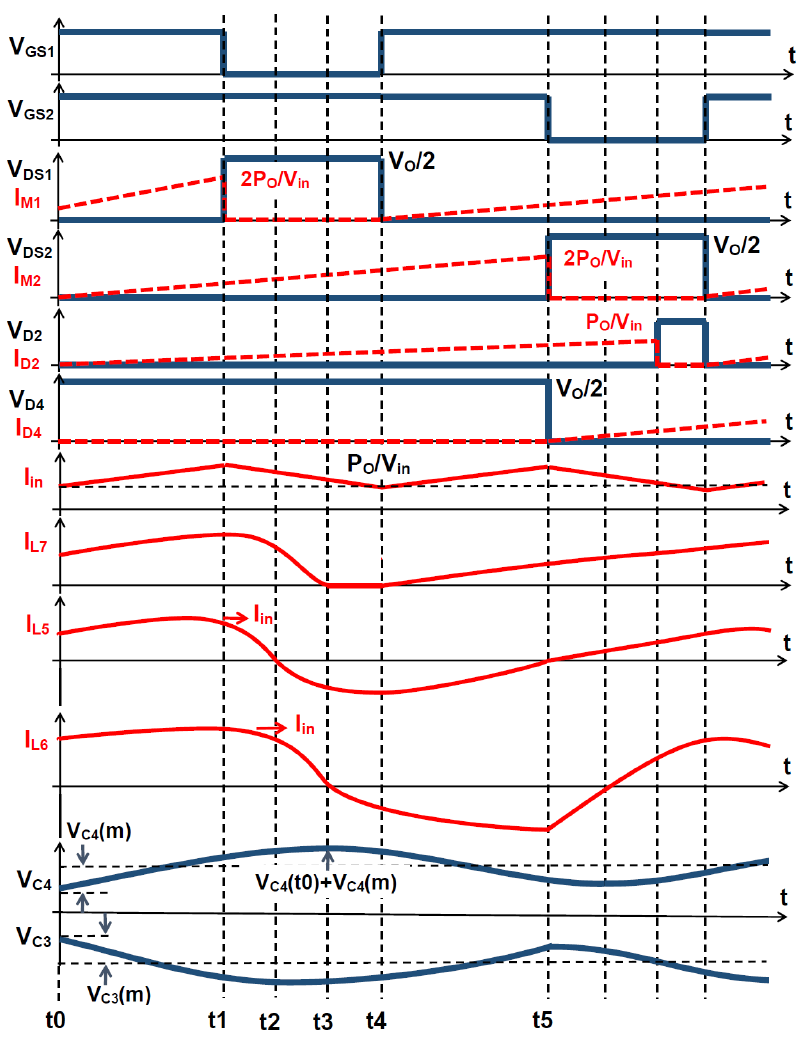
Figure 3. Theoretical waveforms for the proposed converter.